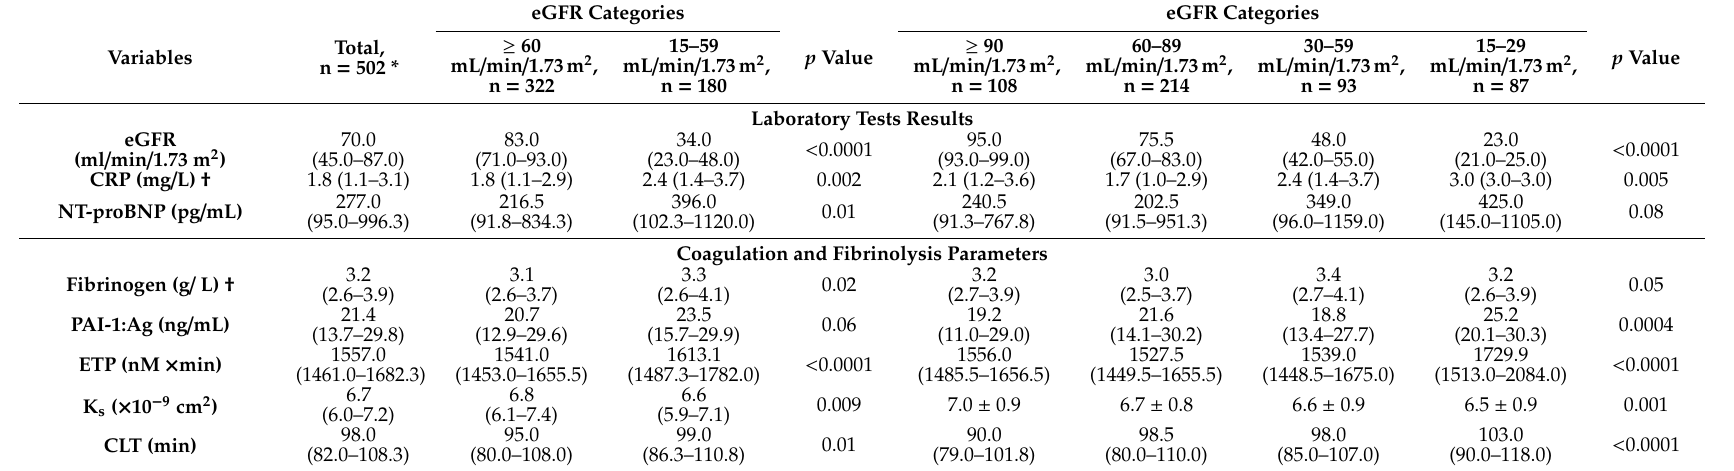
Table 2. Laboratory parameters stratified by estimated glomerular filtration rate (eGFR)